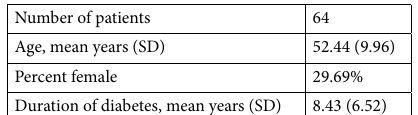
Table 1. Patient population descriptive information at enrollment. SD standard